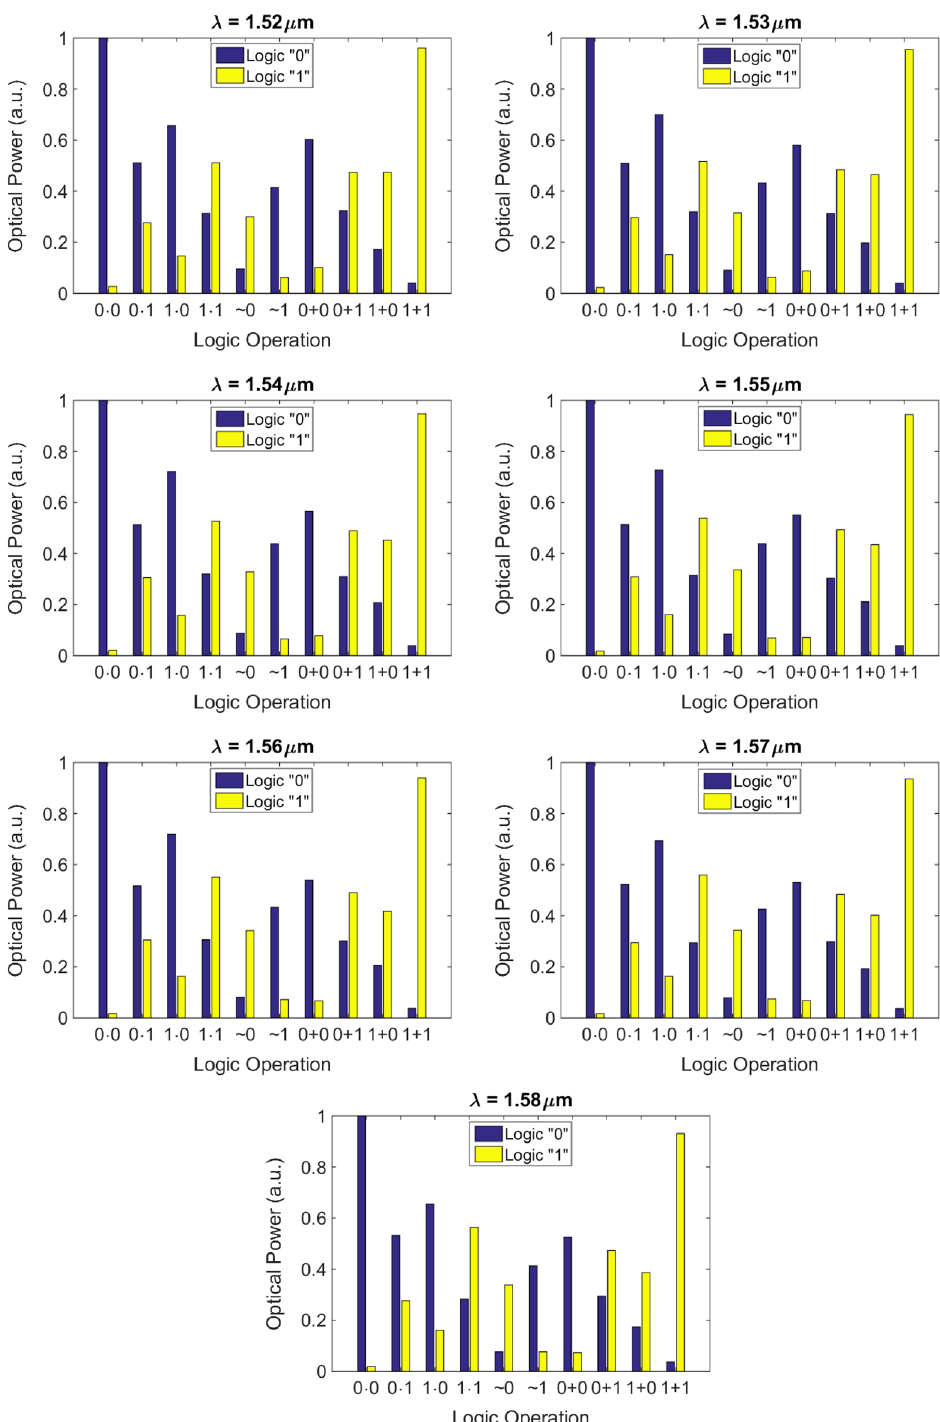
Figure 7. The logic operation of the numerically-trained diffractive model with five diffractive layers at seven different wavelengths in the 1520-1580 µm range. The design parameters of this diffractive model is similar to the design depicted in Fig.